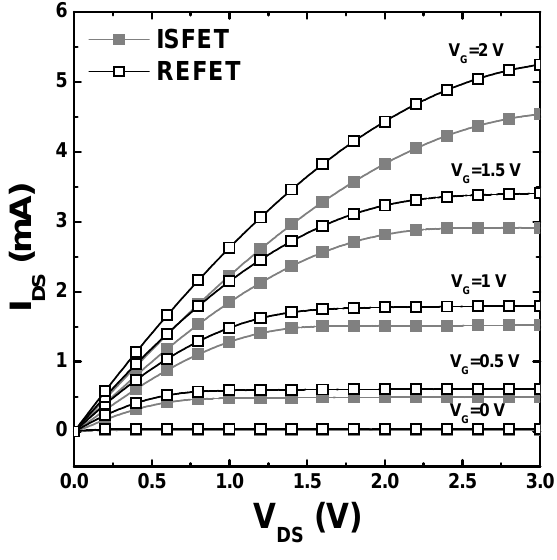
-V curves of ISFETs and REFETs with the gate voltage varied from Figure 5. The I DS DS 0 V to 3